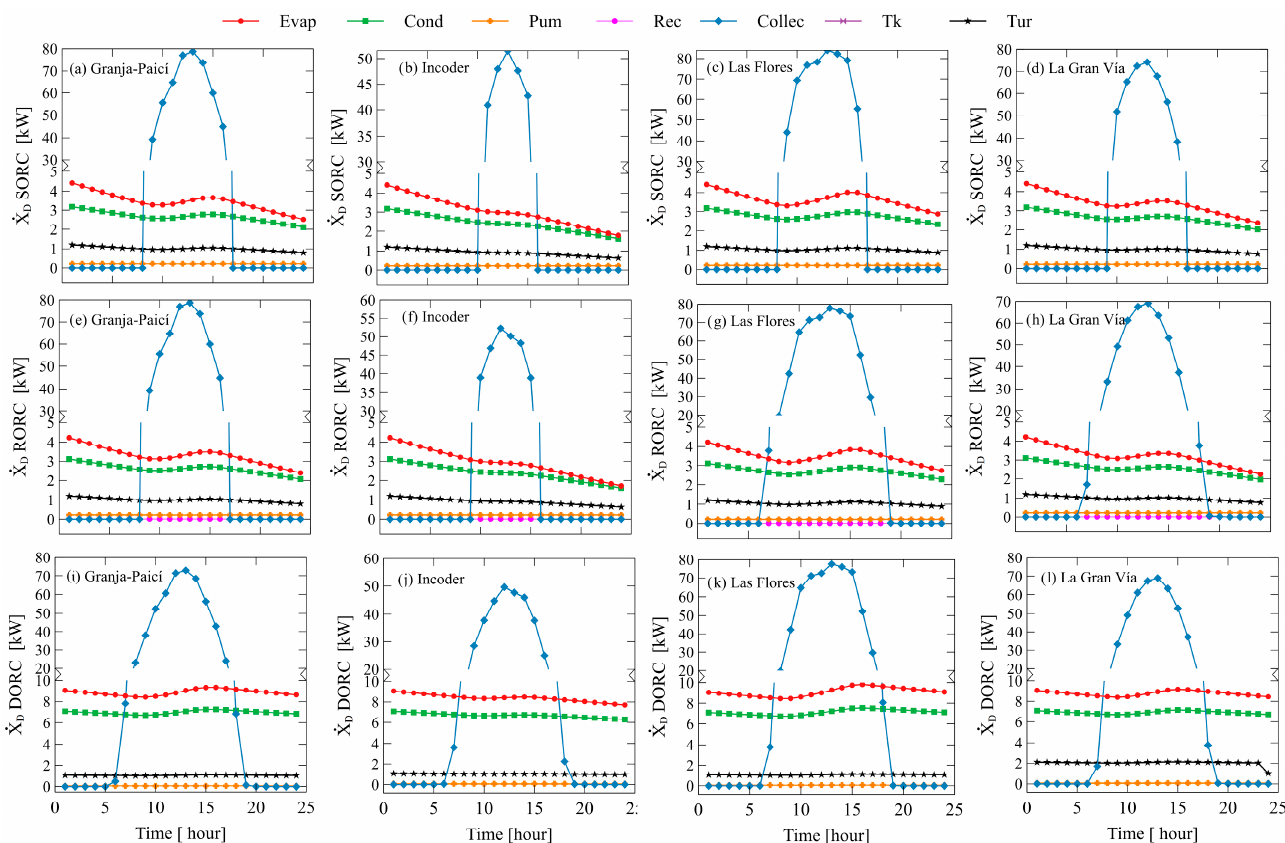
Figure 10. Hourly variation of exergy destruction rates for different configurations and sites.